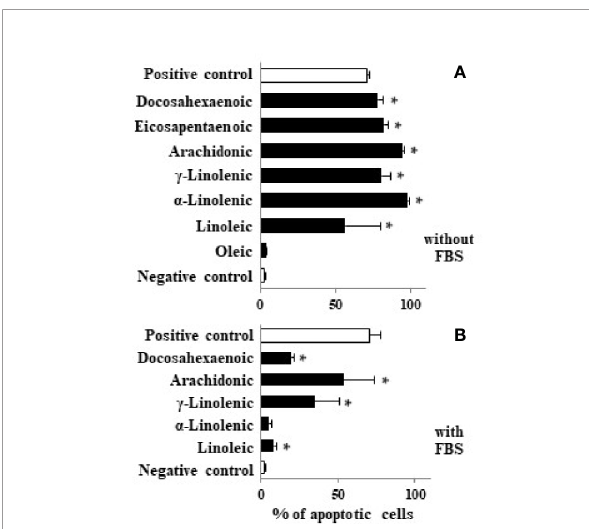
FIGURE 4 | Effect of pharmacological modulation of AA cascade on Caco-2 cell growth induced by oleic and EPA. Caco-2 cells were incubated without FBS for 48 h with oleic or EPA at 10 µM in presence or absence of ketoprofen (Kp, 5 µM), AH23848 (AH23, 20 nM), SC19220 (SC19, 60 nM), baicalein (Bai, 25 µM), MK886 (MK8, 10 µM), U75302 (U75, 5 µM), LY25283 (LY25, 25 µM), MK571 (MK5, 25 µM), or LY171883 (LY17, 25 µM) and cells were counted. Results are expressed as mean ± SEM (n = 8 – 16). *P < 0.05 vs. control group (white bar, cells cultured without FBS), # P < 0.05 versus oleic acid (10 µM), and § P < 0.05 versus EPA (10